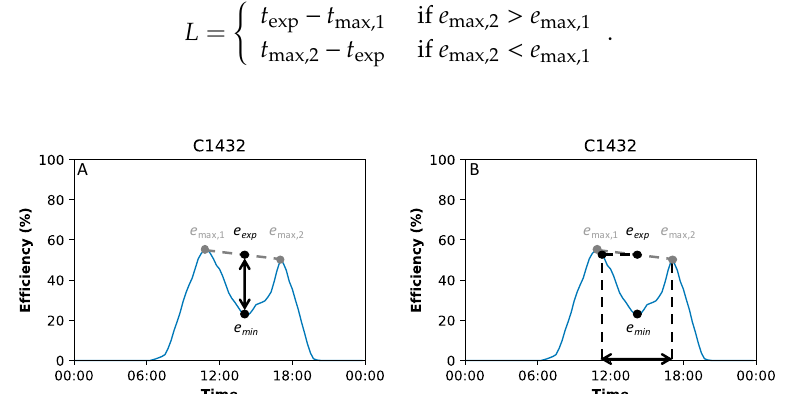
Figure 3. Estimation of daytime shading severity from a weekly mean efficiency curve. ( A ) Shading magnitude, and ( B ) shading length. Blue curves indicate the observed weekly mean efficiency. Black solid circles denote the local efficiency minimum, e min , and the expected efficiency in the absence of daytime shading, e exp . Gray solid circles denote the two local efficiency maxima, e max,1 and e max,2 , associated with daytime shading.